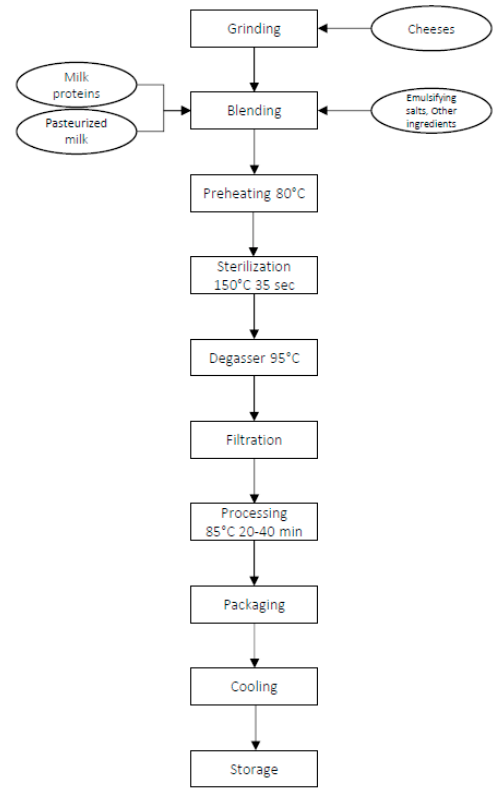
Figure 1. Flow chart of processed cheese production.